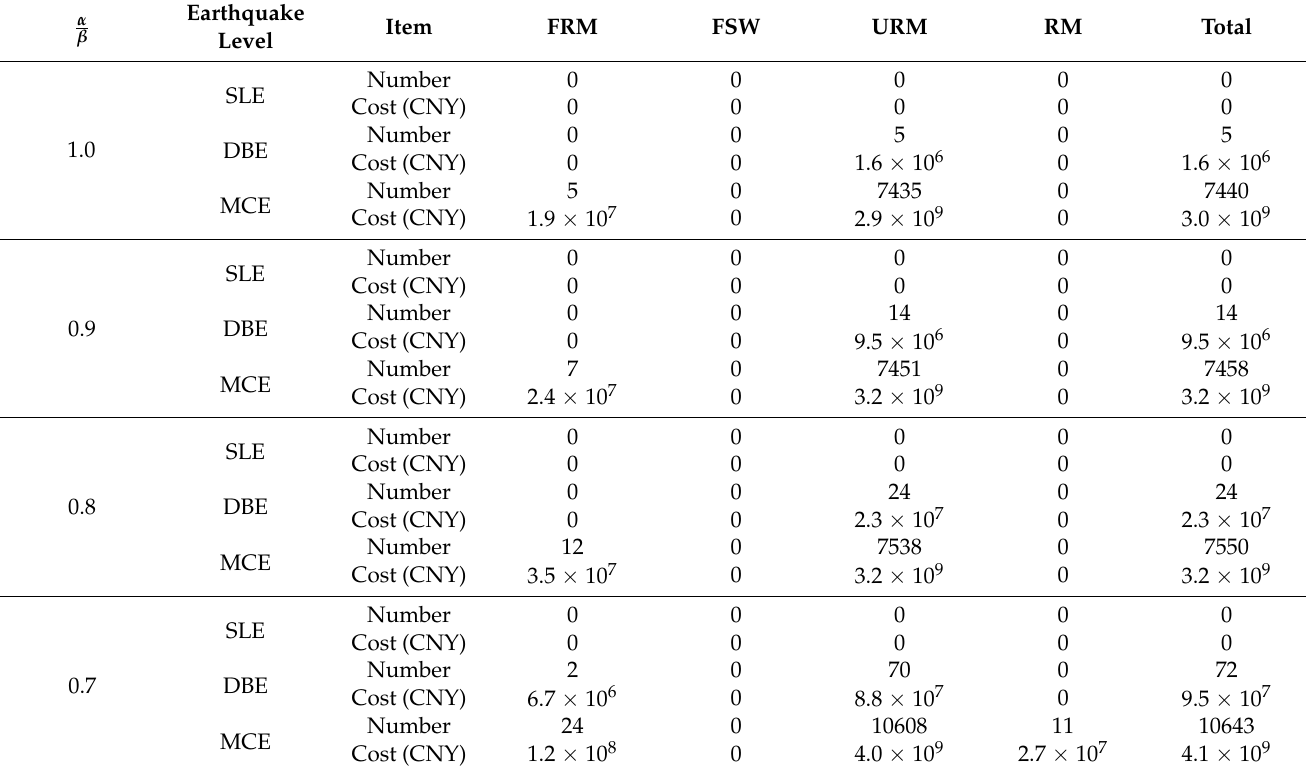
Table 5. Number of buildings requiring retrofitting and corresponding retrofit costs at different α β